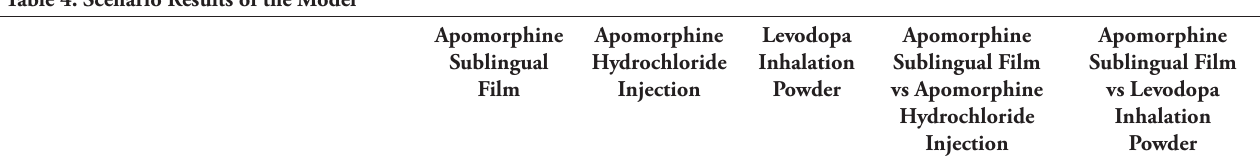
Table 4. Scenario Results of the